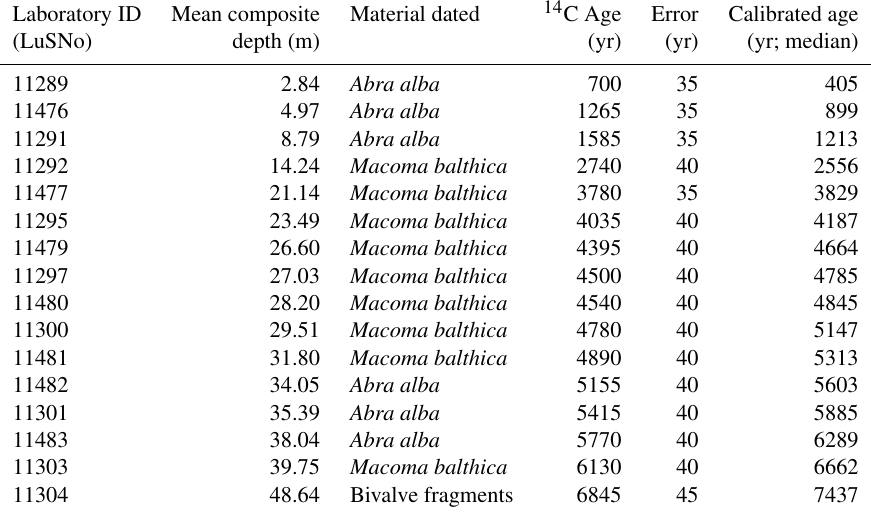
Table 1. Accelerator mass spectrometry radiocarbon dates from Expedition 347 Site M0059; for more detailed information compare Table S1 and Van Helmond et al.